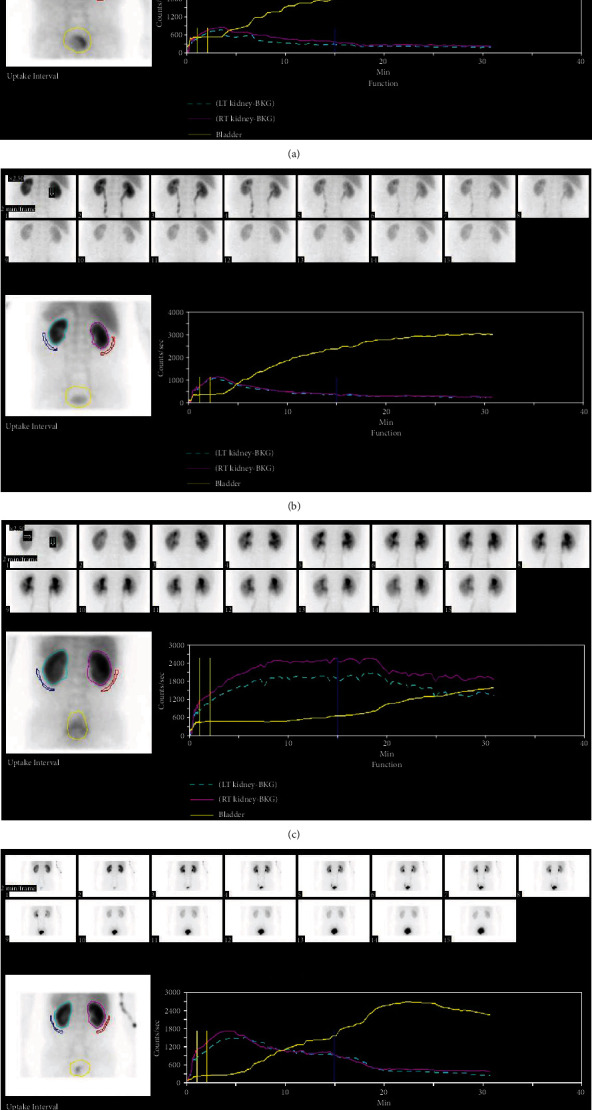
Changes in the T1/2 of the diuretic 99mTc-MAG3 scan according to the preoperative T1/2 of the diuretic 99mTc-MAG3 scan results. (a, b) Preoperative values of the T1/2 of the diuretic 99mTc-MAG3 scan were 7.0 in the left kidney and 9.3 in the right kidney, which means no delay in the T1/2 of the upper urinary tract (a). The values were improved to 4.7 in the left kidney and 5.3 in the right kidney postoperatively (b). (c, d) Preoperative values of the T1/2 of the diuretic 99mTc-MAG3 scan were 73.3 in the left kidney and 44.0 in the right kidney, which means obvious upper urinary tract obstruction (c). The values were markedly improved to 11.6 in the left kidney and 11.6 in the right kidney postoperatively (d).